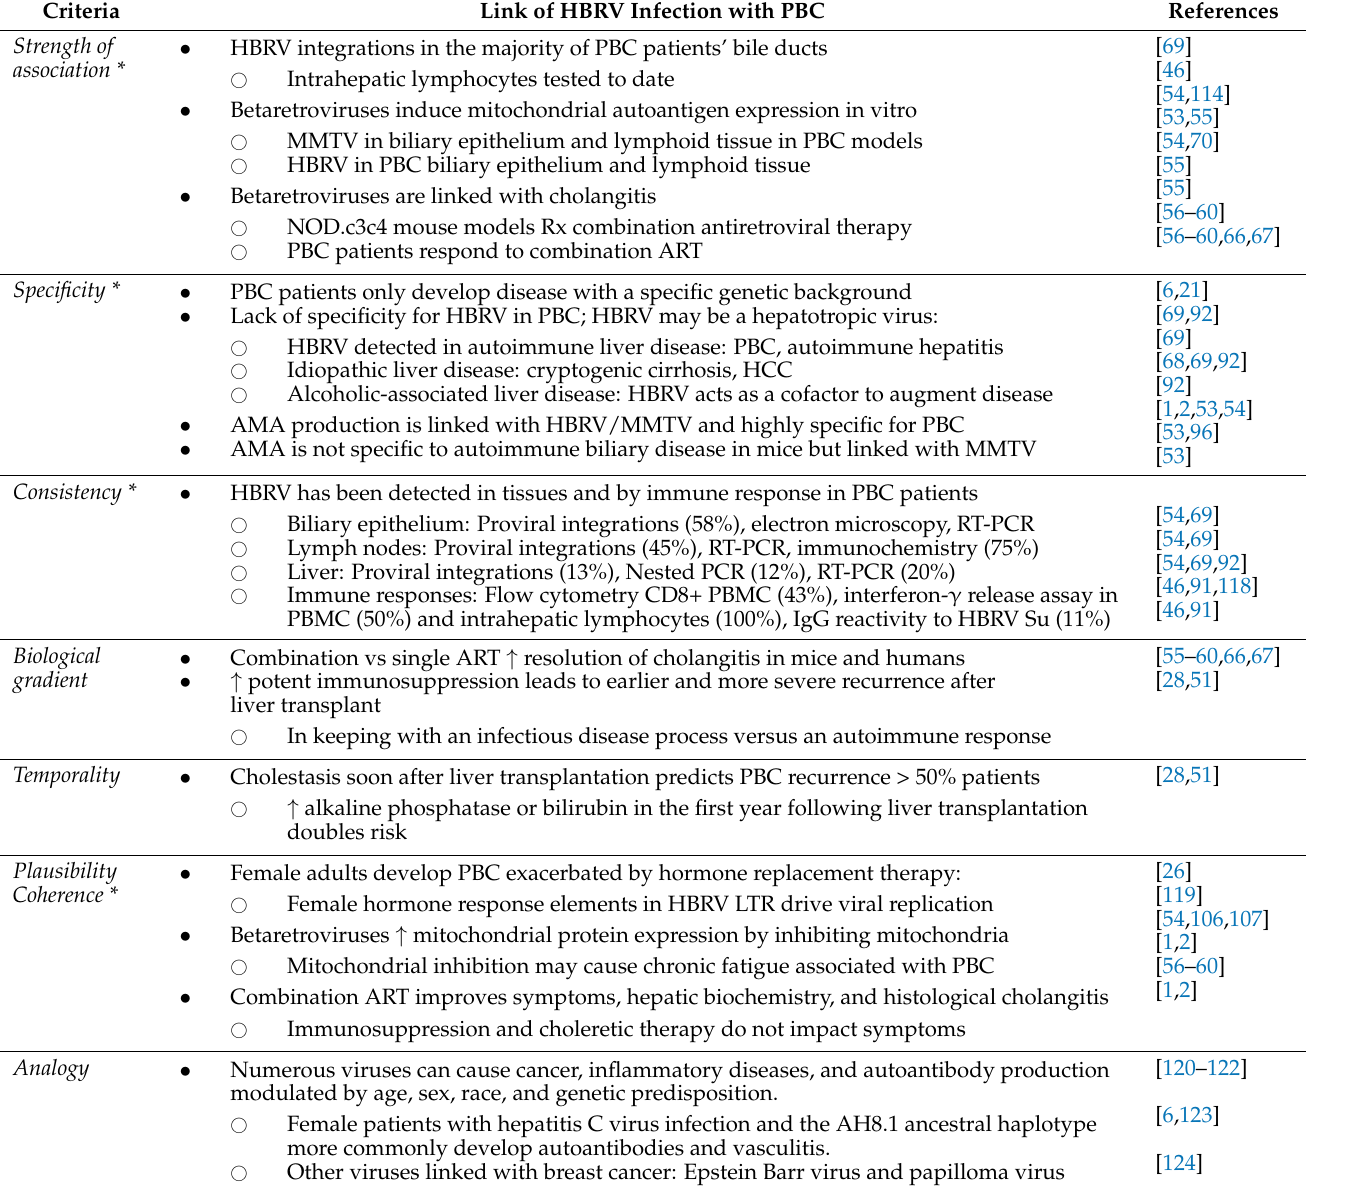
Table 1. Hill’s criteria applied to HBRV infection and